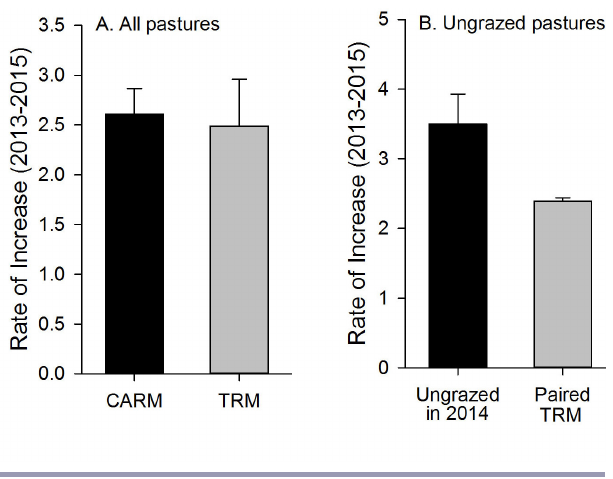
Fig. 6 . Time lags in data availability shaped collaborative adaptive rangeland management (CARM) decision making. After two years, results for vegetation composition were statistically uncertain and “in progress” relative to beef production data, limiting stakeholder use of these data in decision making. The mean rate of increase in Pascopyrum smithii (western wheatgrass) tiller densities between 2013 and 2015 for all 10 pastures (A) was similar across grazing treatments (paired t = 0.25, P = 0.81). The rate of increase for 9 three CARM pastures rested in 2014 was 50% greater than the rate for the three paired, traditionally grazed pastures (B), but statistical support for this difference was marginal (paired t = 2 2.69, P =